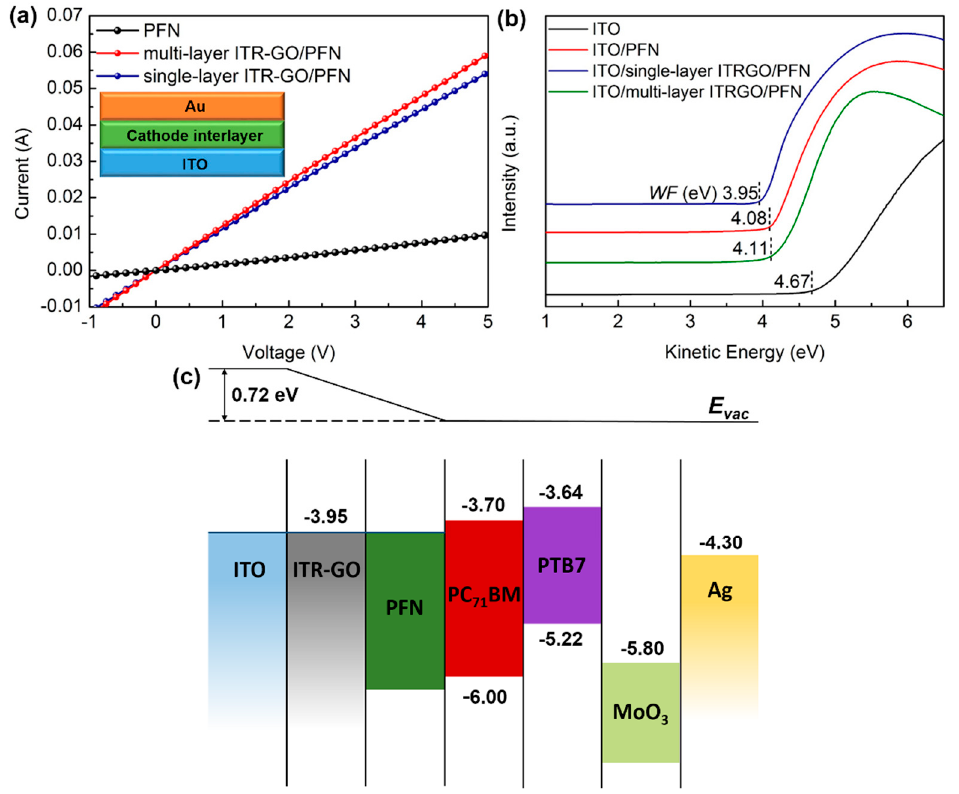
Figure 3. ( a ) Current-voltage curves of the organic solar cells (OSCs) for ITO/CILs/Au. ( b ) Ultraviolet photoelectron spectroscopy (UPS) cutoff of ITO substrates with various layers on top. ( c ) Schematic energy levels of the inverted device.